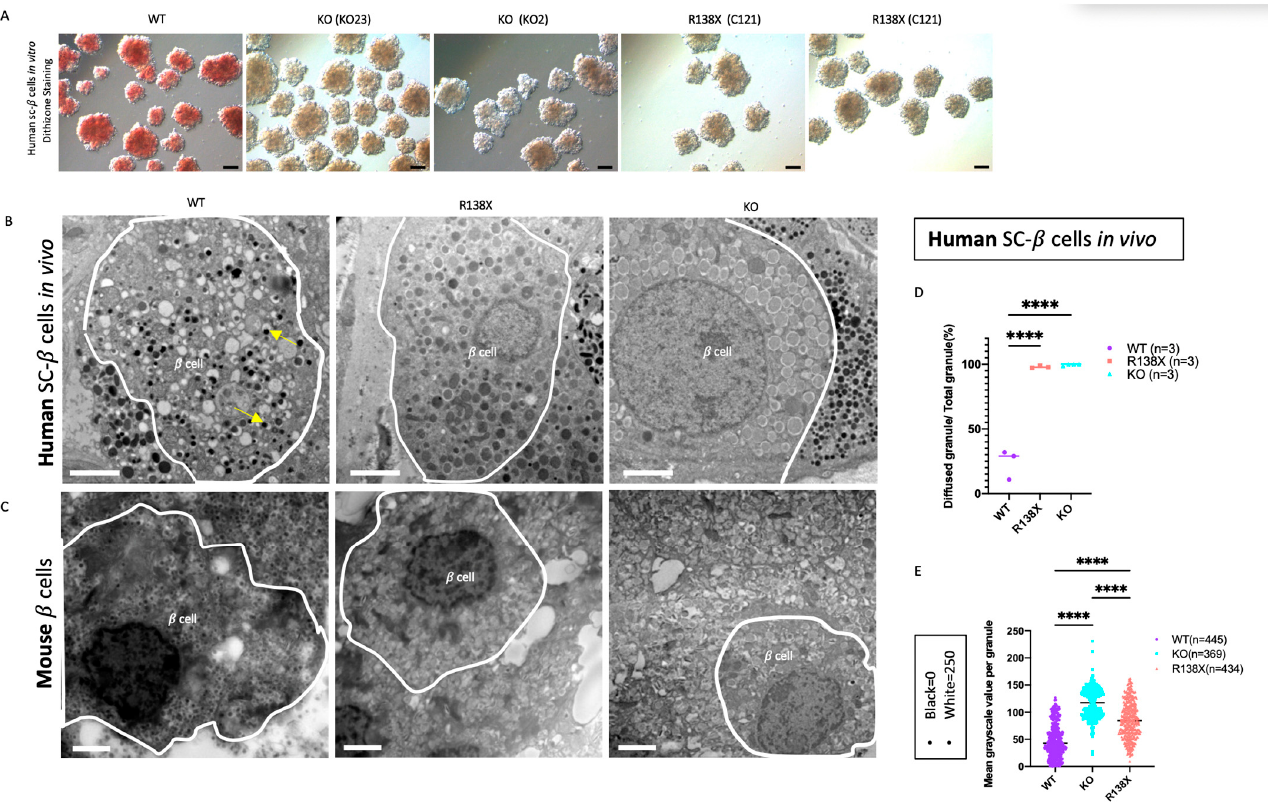
Figure 2. Stem cell-derived beta cells with R138X and KO mutations are zinc depleted and diffused cores are formed in insulin granules. ( A ) Representative bright view pictures of stem cell-derived beta cell clusters with dithizone staining. Scale bar: 100 μ m. ( B ) Representative electron microscopy pictures of insulin granules in grafted cells isolated from mice transplanted with WT, R138X, and KO stem cell-derived beta cell clusters for 8 months in vivo. Scale bar: 2 μ m. ( C ) Representative electron microscopy pictures of insulin granules in a beta cell of WT mice and R138X mice under chow diet and KO mice under high fat diet. Scale bar: 2 µ m. ( D ) Quantification of diffused granules out of total granules in WT, R138X, and KO in percentage: WT ( n = 3), R138X ( n = 3) and KO ( n = 3). One-way ANOVA with **** p < 0.0001 for WT vs. R138X and WT vs. KO. ( E ) Quantification of mean grayscale value per granule among WT ( n = 445), KO ( n = 369) and R138X ( n = 434) in ( B ) and not shown. (Black = 0, white = 250; higher grayscale value means lighter in brightness). One-way ANOVA, p **** < 0.0001 for WT vs. R138X and WT vs.